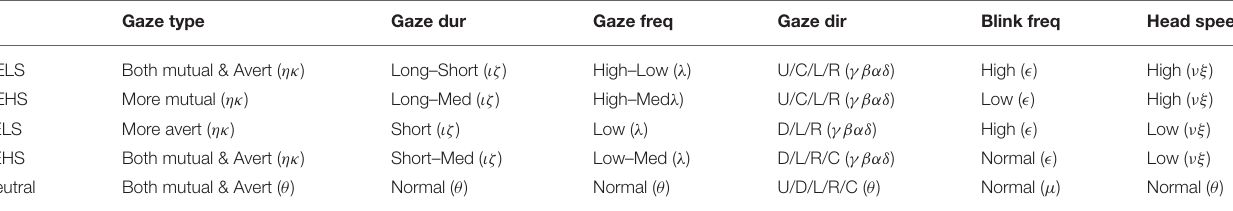
TABLE 3 | Summary of empirical findings on the expression of personality traits through gaze behaviour.